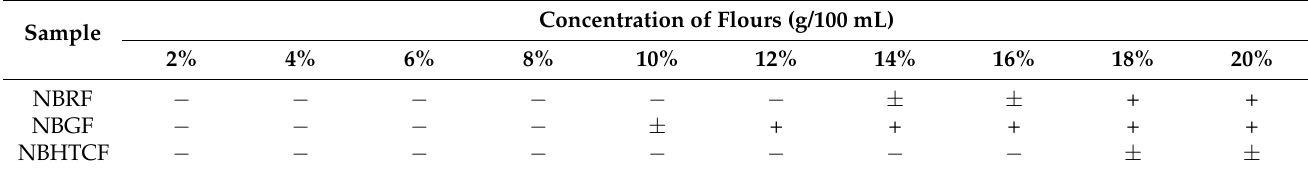
Table 4. Least gelation concentrations of Nitta bean raw, germinated, and hydrothermally cooked flours. Concentration of Flours (g/100 mL) Sample